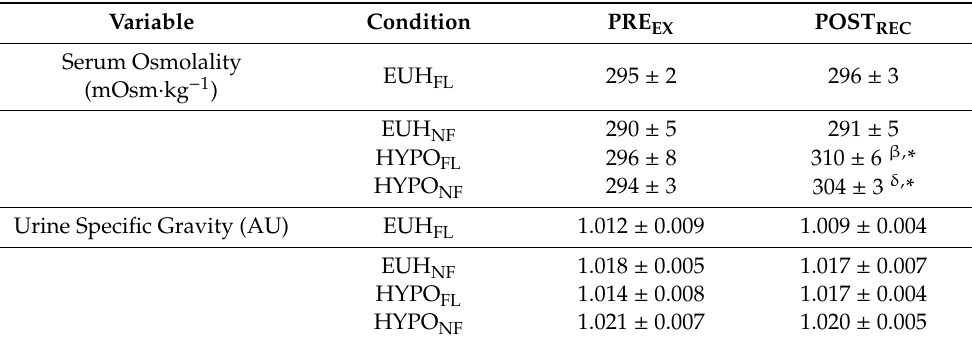
Table 2. Serological and urinary hydration